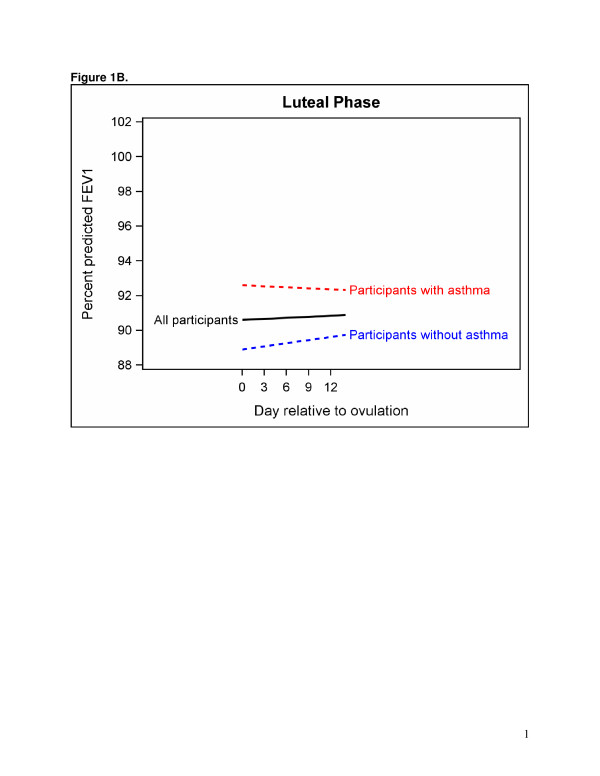
The log of E1C/PDG ratio of hormone levels (x axis) associated with percent predicted FEV1 (y axis) in the follicular phase among all women. For purposes of illustrating the relationship between hormones and FEV1, the menstrual segment day is held constant at 7 days prior to ovulation date for the plot.